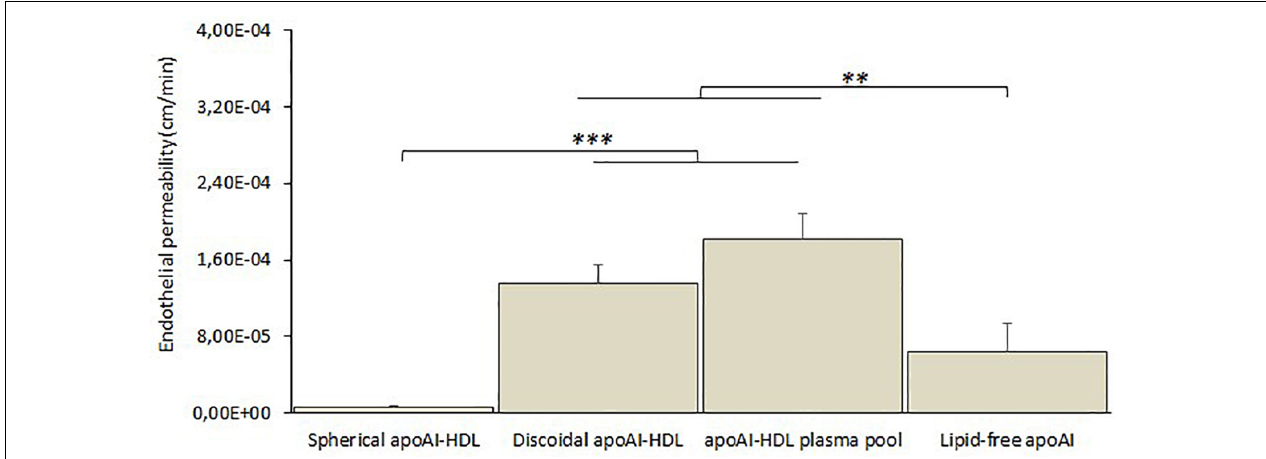
FIGURE 6 | In vitro BBB crossing of different subclasses of human plasma HDL. The passage of apoA-I in different lipidation states (spherical apoA-I-HDL, discoidal apoA-I-HDL, apoA-I-HDL plasma pool, or lipid-free apoA-I) across the hCMEC/D3 monolayer was determined by measuring apoA-I in the lower compartment of the transwell system at different incubation times (up to 3 h) by ELISA assay. Data were expressed as endothelial permeability (EP), reported as the mean ± SEM of triplicate experiments. One-way ANOVA found a significant difference [ F ( 3 , 32 ) = 75.14; p = 0.00001]. ∗∗ p < 0.01, ∗∗∗ p < 0.01 by Tukey’s post hoc test.